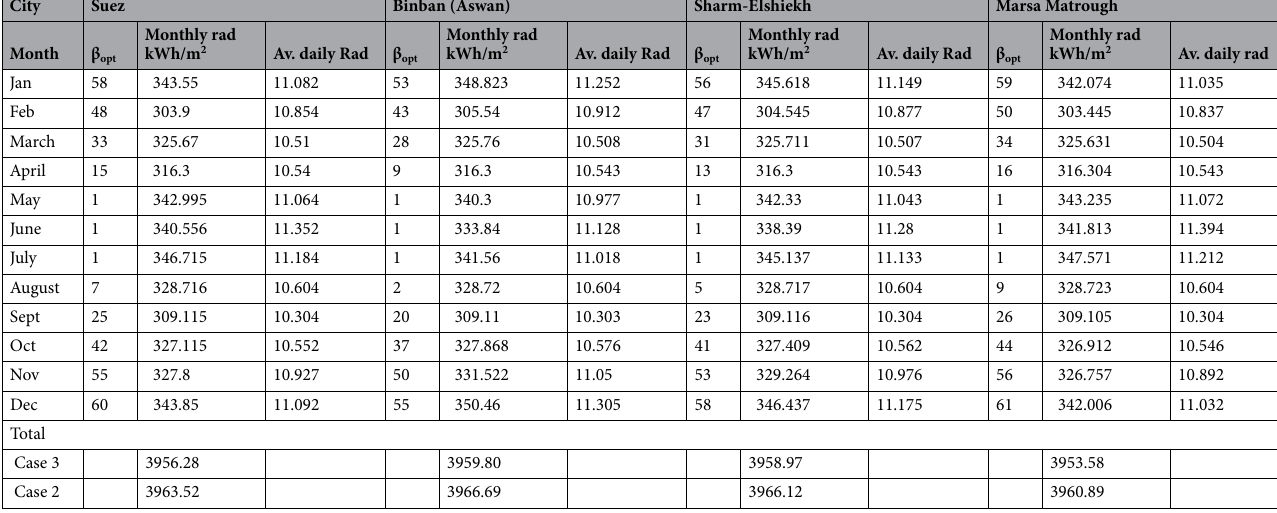
Table 2. Monthly radiation at monthly optimal